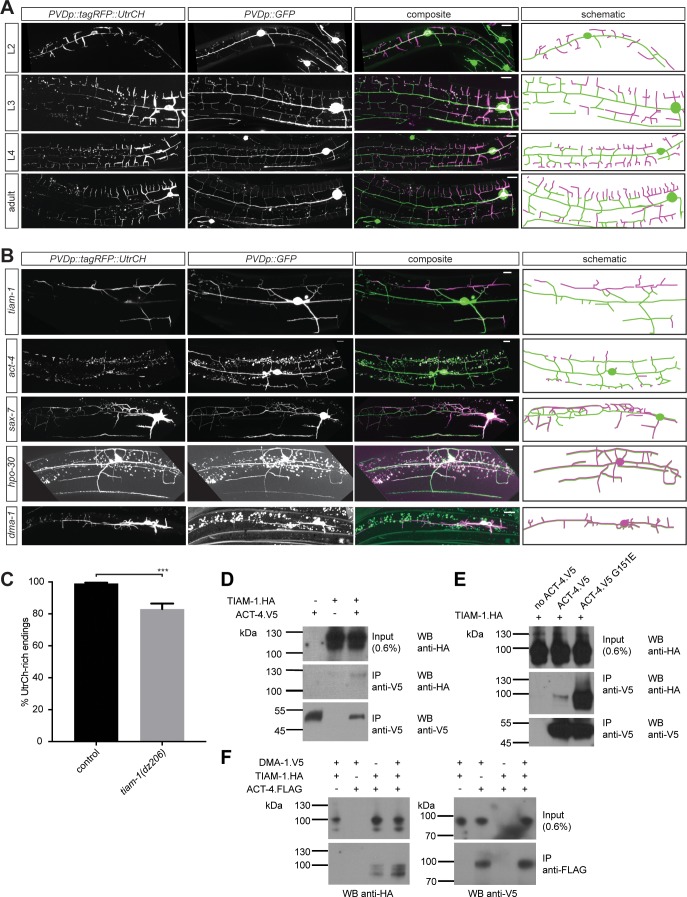
F-actin is localized to the leading edges of developing dendrites and requires the Menorin pathway for polarized localization.(A) Fluorescent images of animals at different developmental stages carrying a F-actin reporter (ser-2p3::tagRFP::UtrCH [dzEx1564], left panels), a PVD cytoplasmic GFP reporter (wdIs52 [F49H12.4p::GFP], second panels), merged images (third panel), and corresponding schematics (right panels). L2: second larval stage, L3: third larval stage, L4 fourth larval stage. Scale bars indicate 10 µm. (B) Fluorescent images of animals in different genetic backgrounds carrying a F-actin reporter (ser-2p3::tagRFP::UtrCH [dzEx1564], left panels), a PVD cytoplasmic GFP reporter (wdIs52 [F49H12.4p::GFP], second panels), merged images (third panel), and corresponding schematics (right panels). Genotypes are indicated on the left. Scale bars indicate 10 µm. (C) Quantification of dendrite termini with F-actin rich staining in wild-type control (n = 10) and tiam-1(tm1556) mutant animals (n = 13). For details on quantification see Materials and methods. For raw data see Figure 1— source data 1. Statistical significance is indicated as Data are represented as mean ±SEM. Statistical comparisons were performed using the Mann-Whitney test. Statistical significance is indicated (***, p<0.005). (D – F) Western blots of co-immunoprecipitation experiments analyzing the interaction between TIAM-1 and wild type ACT-4 or mutant ACT-4(G151E). Transfected constructs are indicated above the panels. Antibodies used for immunopreciptation (IP) and western blotting (WB) are indicated. A molecular marker is on the left. Note, that panels in F are from a single western blot, which was developed repeatedly with two different antibodies after stripping. Similar results were obtained from at least three independent replicate experiments.